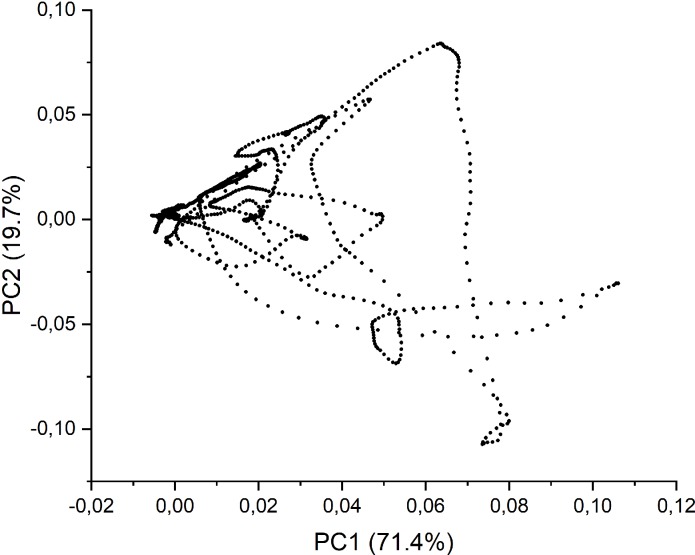
The loading plot from PCA.